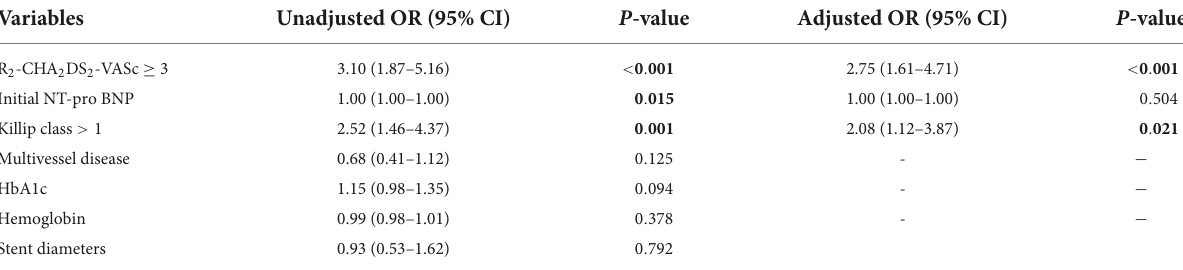
TABLE 2 Results of the univariate and multivariate regression analyses for the predictors of the no-reflow phenomenon. Variables